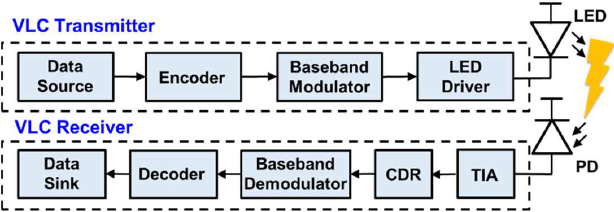
Figure 1. Architecture of traditional integrated VLC transceiver system.